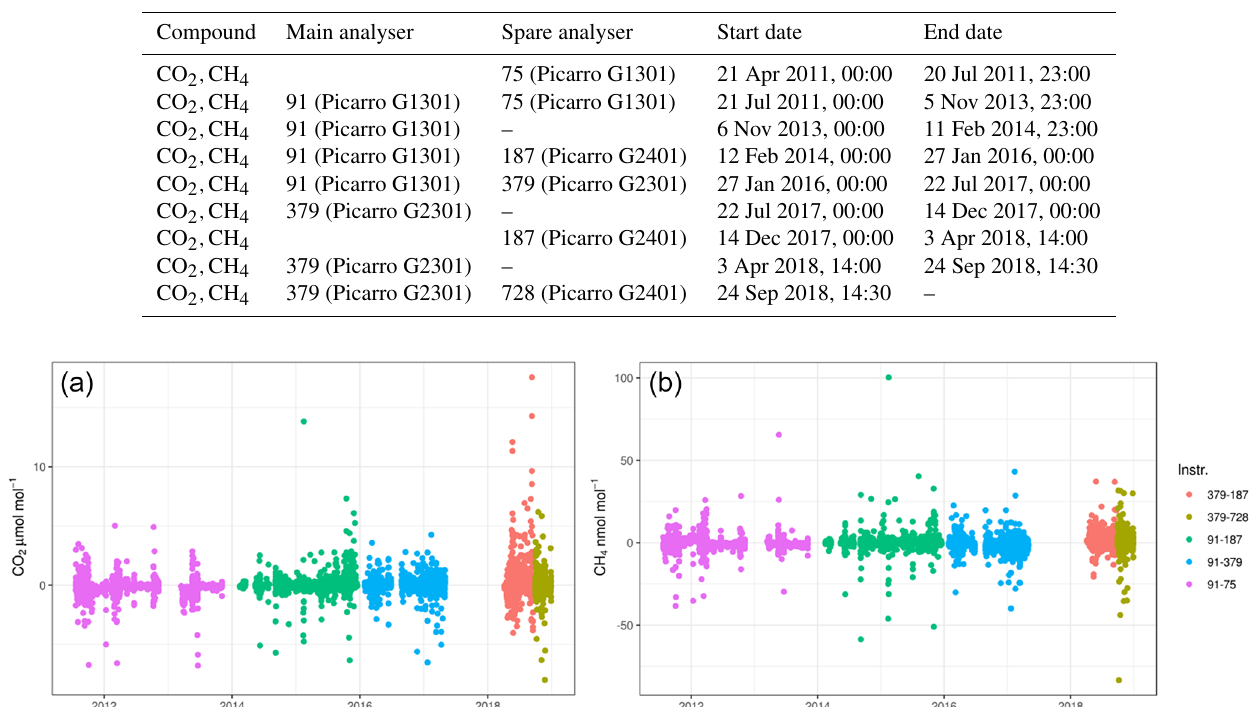
Table 2. Order of priority (main vs. spare analysers) for CO 2 and CH 4 with ICOS instrument identifiers and the associated period.